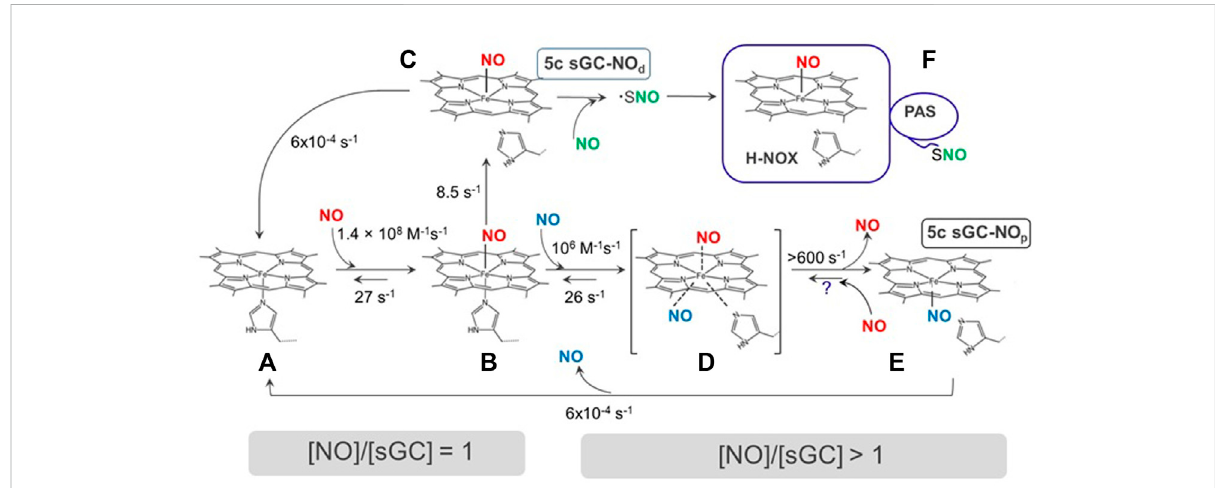
FIGURE 2 The interactions of NO with sGC. sGC (A) reversibly binds to NO to form a 6c sGC-NO complex (B) . The 6c sGC-NO complex subsequently converts to a 5c sGC-NO d complex (C) irreversibly due to the rupture of Fe-His bond. NO in the 5c sGC-NOd presumably stays on the distal side of heme(denotedbythesubscript “ d ” ).InthepresenceofexcessNO,asecondNObindstoBtoformatransientternarycomplex (D) ,whichconvertsto another 5c sGC-NO dp complex (E) rapidly from both Fe-His bond rupture and dissociation of distal NO. NO in (E) presumably stays on the proximal side of the heme (denoted by subscript “ p ” ). Species (F) with S -nitrosylthiol(s) may form in the excess of NO. Question mark represents an uncon fi rmed reaction.